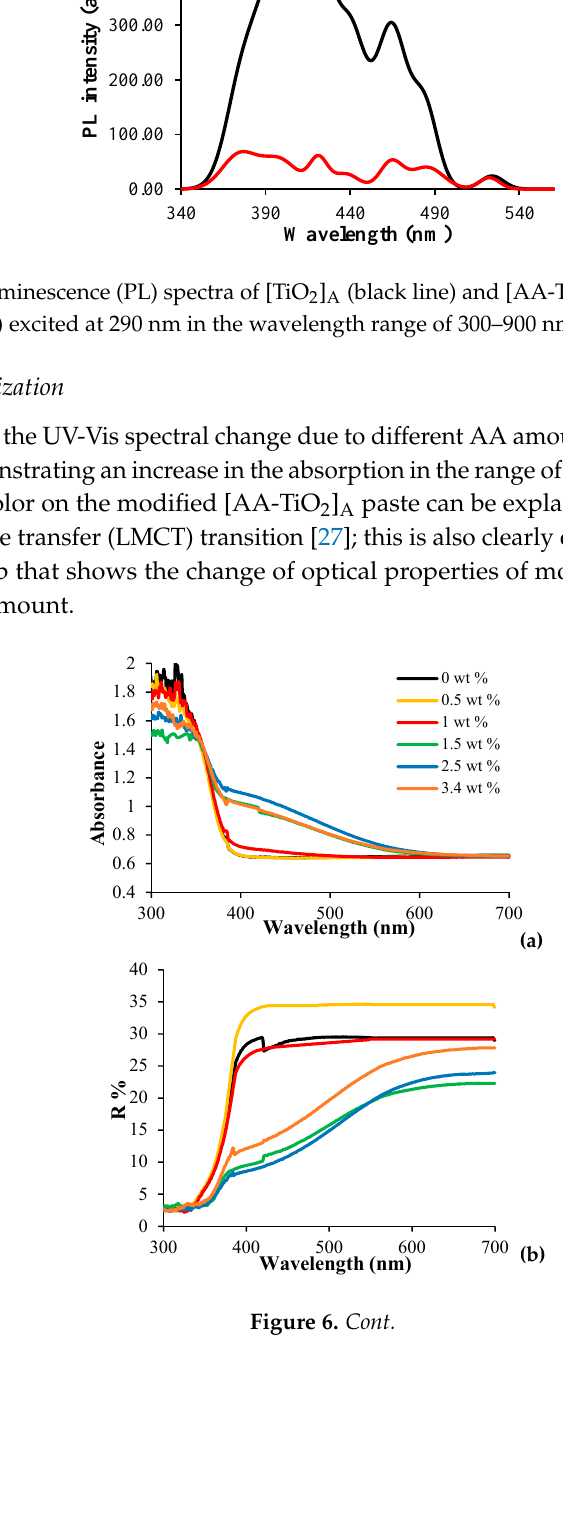
Figure 7. Langmuir isotherm graph for ARS adsorption on [PP@AA ‐ TiO 2 ] A . C e / Q e = 0.0152 C e + 0.1225 R ² = 0.9186 00.050.10.150.2 0.25 0.30.350.40.450.5 0